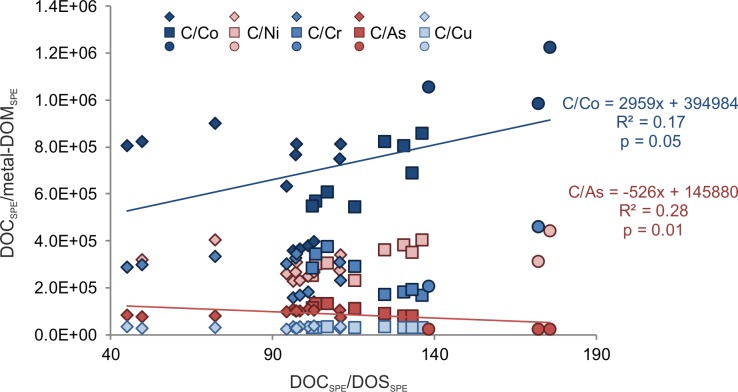
Correlation of trace metal and DOS stoichiometry.Correlation of DOCSPE/metal-DOMSPE versus average DOCSPE/DOSSPE of pH 2 extracted samples. Linear correlation of DOCSPE/Co-DOSPE and DOCSPE/As-DOMSPE is shown. Symbols represent sampling locations: River Weser (W1, W2; squares), River Elbe (E1 - E3; diamonds) and the marine station (M1; circles).